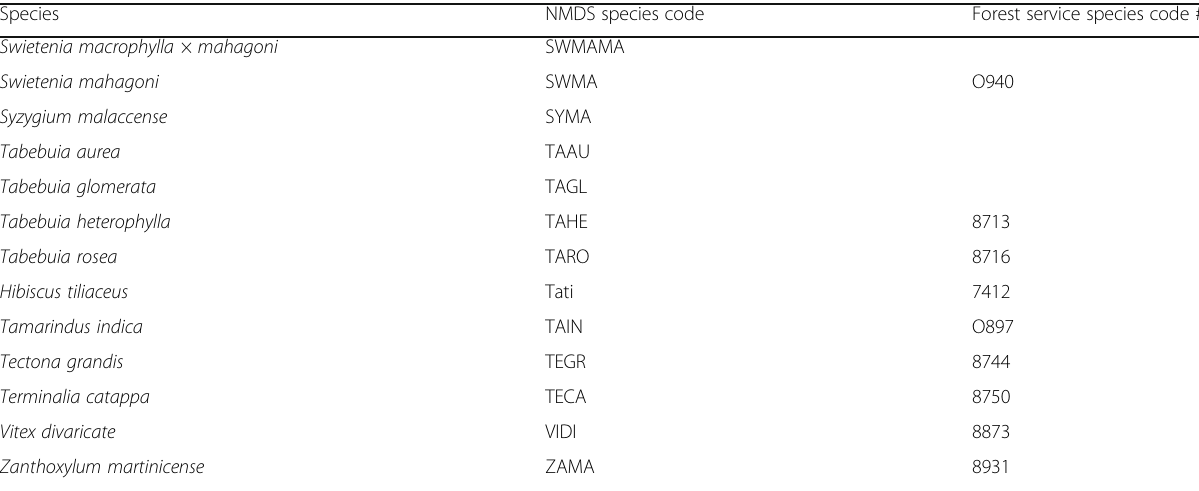
Table 7 Species found in JB-BN with species codes used in the Appendix 1 NMDS ordinations and found in Appendix G of the For- est Inventory and Analysis (FIA) user guide